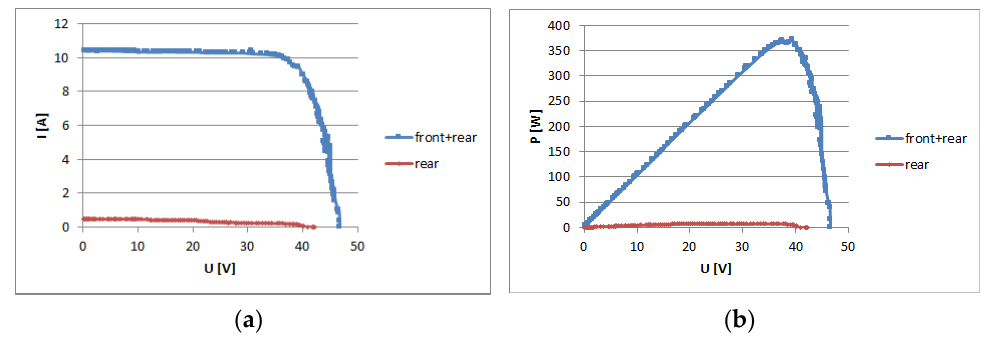
Figure 15. The whole vs. rear side yield characteristics benchmark in a bifacial module: ( a ) current- voltage characteristics; ( b ) power-voltage characteristics for 60° inclination over the grass substrates.